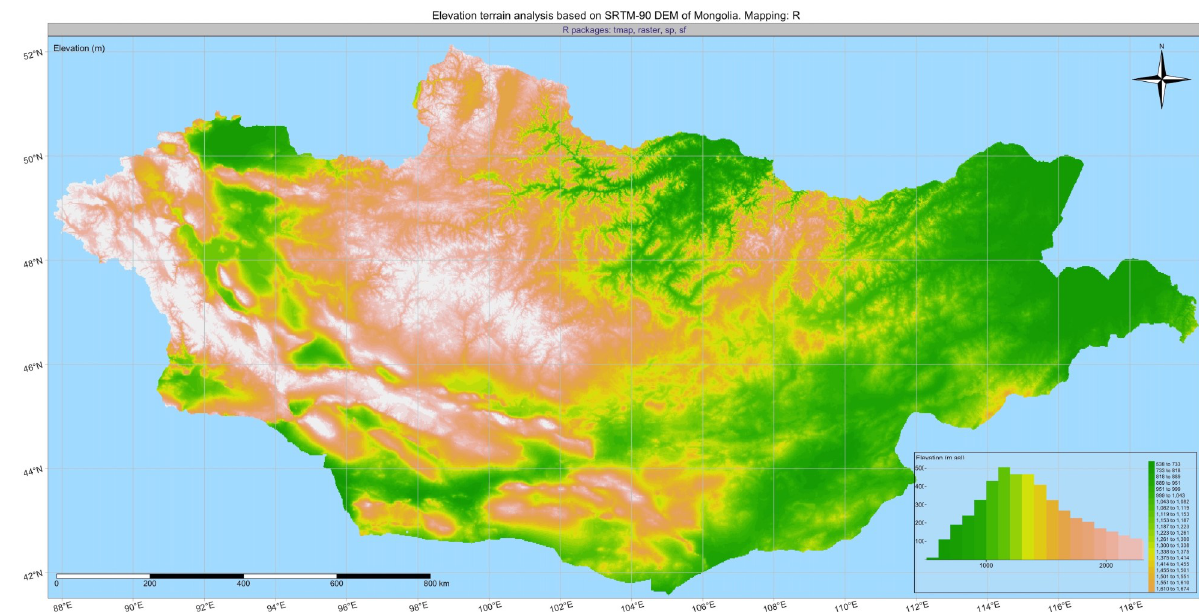
Fig. 6. Elevation model based on SRTM-90 DEM of Mongolia. Mapping: R. Source: author.